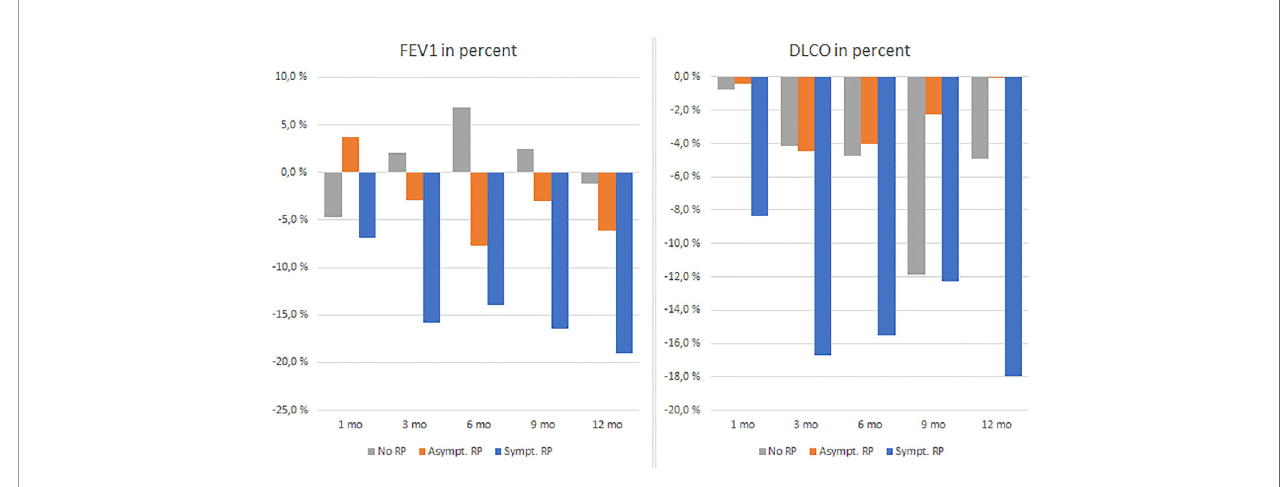
FIGURE 3 | FEV1 and DLCO in percent changes in three groups 1 – 12 months.